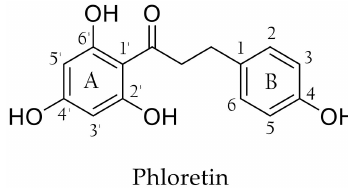
Figure 1. Structure of